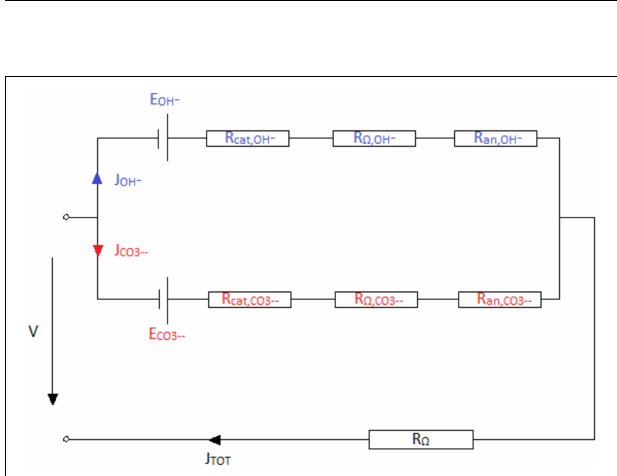
FIGURE 5 | Molten carbonate fuel cell (MCFC) operation with both charge carriers, redrawn from (Rosen et al., 2020).